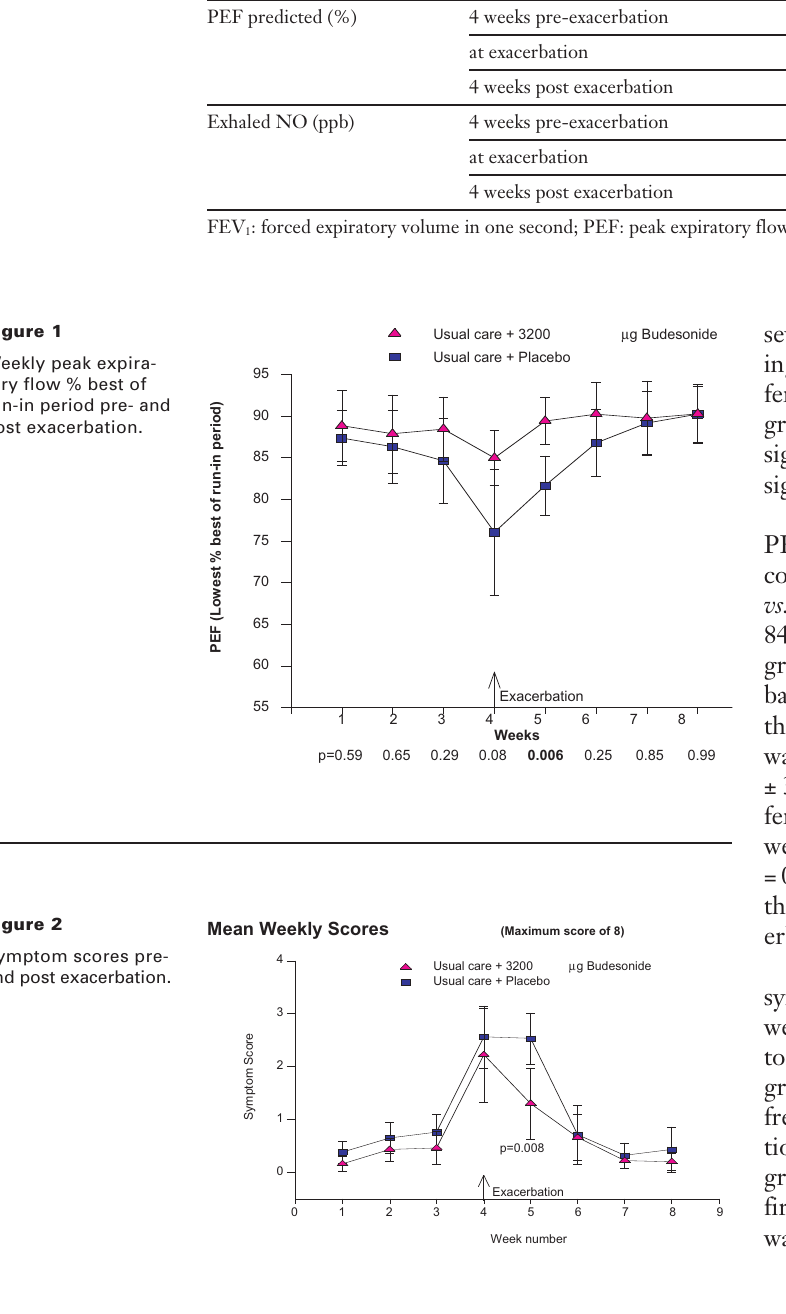
Values for 19 subjects, showing FEV 1 % pre- dicted and eNO at exacerbation and 4 weeks post exacer-